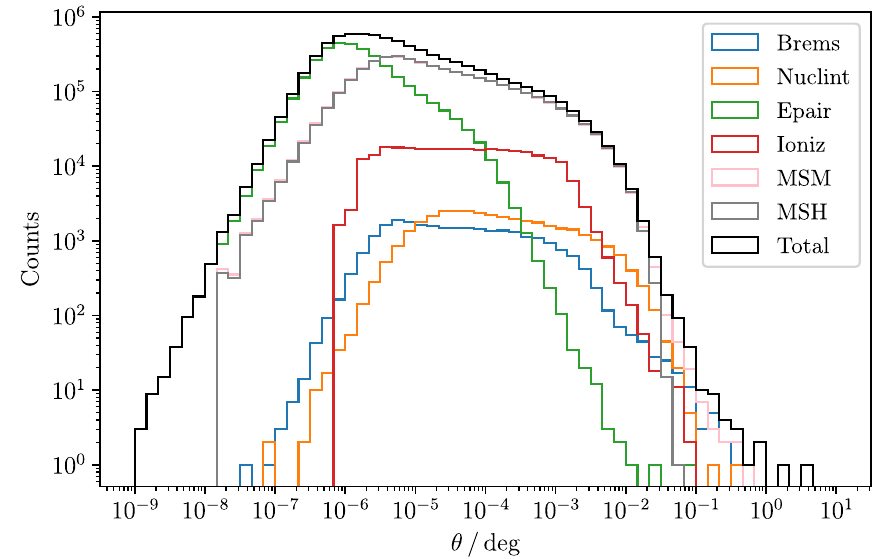
Fig. 1 The muon deflection θ per interaction in degree is shown for different mechanisms. The propagation is done for 1000 muons from E i = 1 PeV to E f , min = 1 TeV using e cut = 500 MeV and v cut = 0 . 05 inice.ThestochasticinteractionsarestatedasBremsstrahlung(Brems), photonuclearinteraction(Nuclint),electronpairproduction(Epair),and ionization(Ioniz).Twosimulationsaredonetocheckbothmultiplescat-